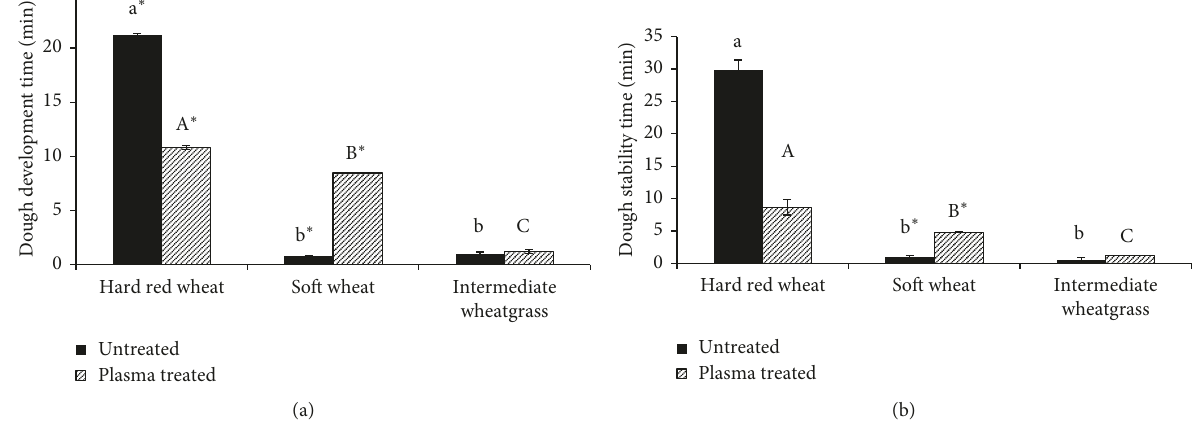
Figure 2: Dough development time (a) and stability (b) of hard red wheat, soft wheat, and intermediate wheatgrass flour. Error bars represent standard deviations ( n � 2), and different lowercase and uppercase letters represent differences ( p < 0 . 05) between flour types before and after plasma treatment (assessed by Tukey’s HSD test), respectively. Asterisks represent differences ( p < 0 . 05) within the same flour type due to plasma treatment (assessed by a paired t -test).